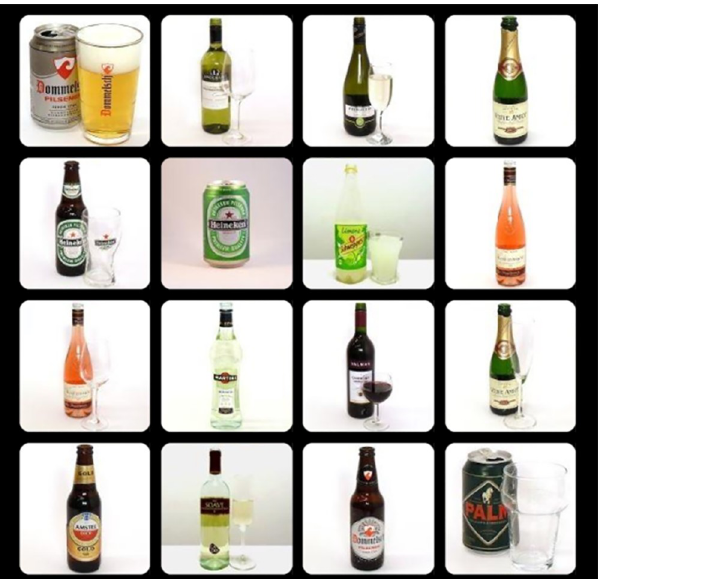
Fig 1. Example of an alcohol distractors trial of the VST.